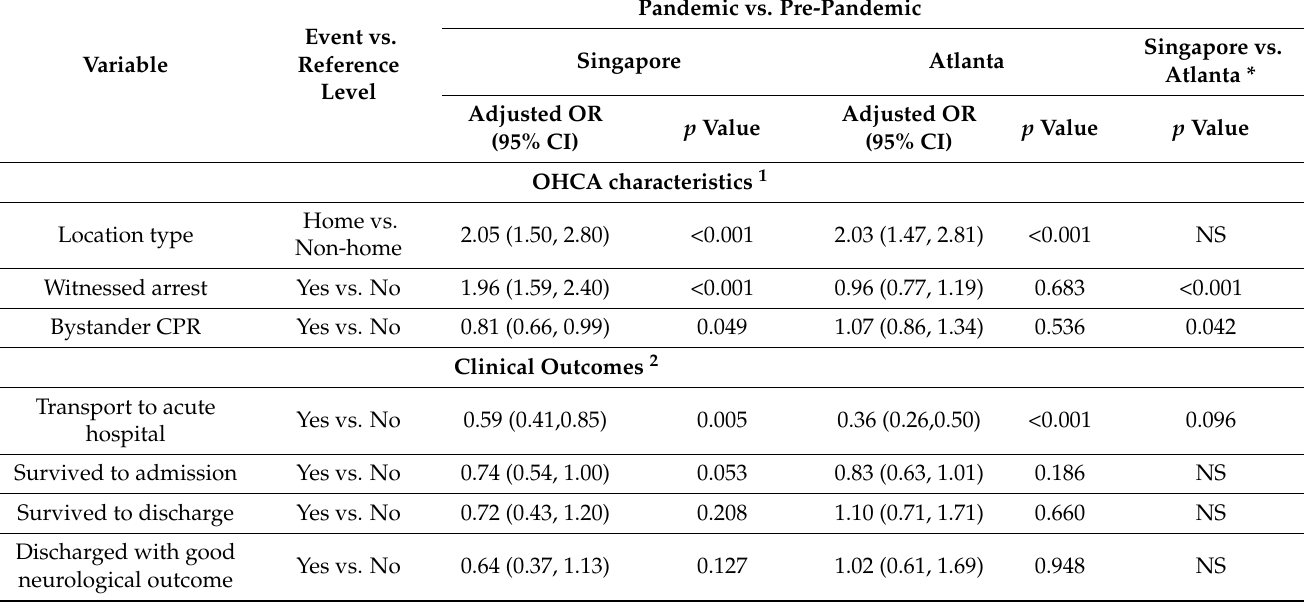
Table 4. Multivariable logistic regression of OHCA event characteristics and outcome between pandemic and pre-pandemic